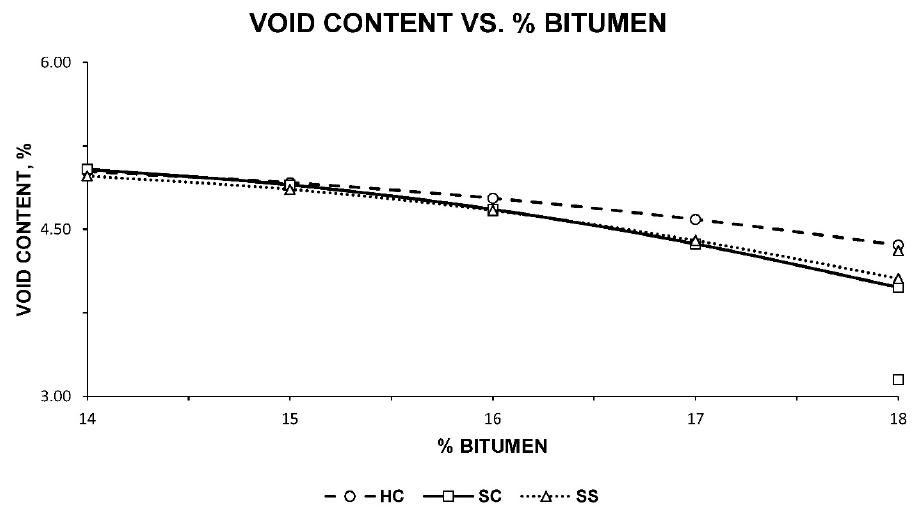
Figure 7. Maximum density of the HC, SC, and SS families of bituminous mixtures according to the percentage of bitumen. On the other side, the determination of the void content in the mix from the maxi ‐ mum density and the bulk density is essential. The void content is reflected in Figure 8 for all families of bituminous mixtures.